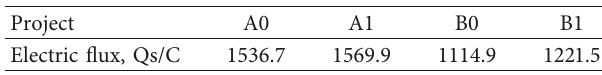
Figure 3: Relationship between gas film structure and thermal energy conversion. Table 3: Effect of antisegregation agent on electric flux of